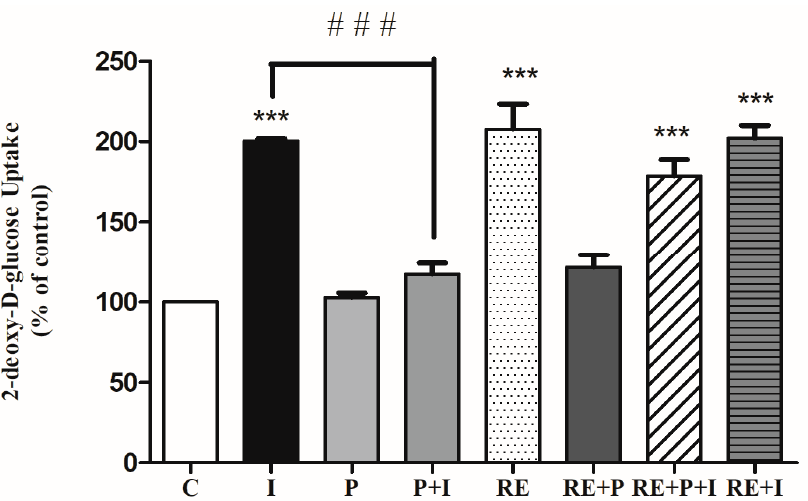
Figure 2. Rosemary extract (RE) restores the insulin-stimulated glucose uptake in palmitate treated muscle cells. Fully differentiated L6 myotubes were treated without (control, C) or with 0.2 mM palmitate (P) for 16 h in the absence or the presence of 5 µ g/mL RE followed by stimulation without or with 100 nM insulin (I) for 30 min and [3 H ]-2-deoxy- D -glucose uptake measurements. The results are the mean ± standard error (SE) of 4–7 independent experiments, expressed as percent of control (*** p < 0.001 vs. control, ### p < 0.001 vs. insulin alone).